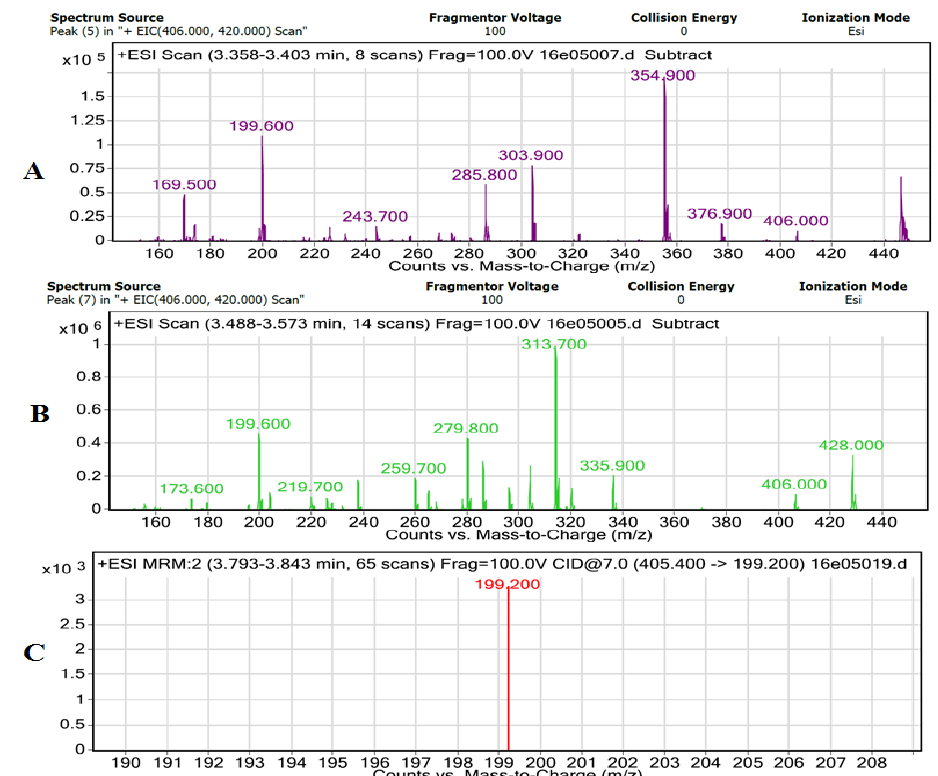
Figure 5. Mass spectra analyses. ( A ) LC–MS + ESI scan of lovastatin with lactose as a C-source; ( B ) LC–MS + ESI scan of lovastatin with eucalyptus leaves as a C-source; ( C ) MS–MS ion mass spectra of lovastatin with eucalyptus leaves as a C-source.